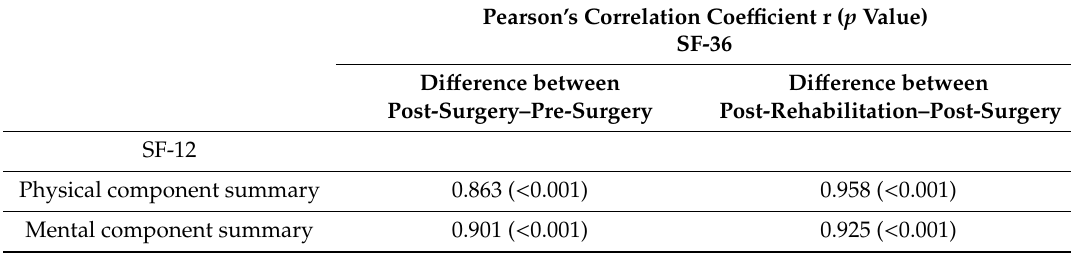
Table 4. The connection of component di ff erences (post-surgery—pre-surgery; post-rehabilitation— post-surgery) SF-36 and